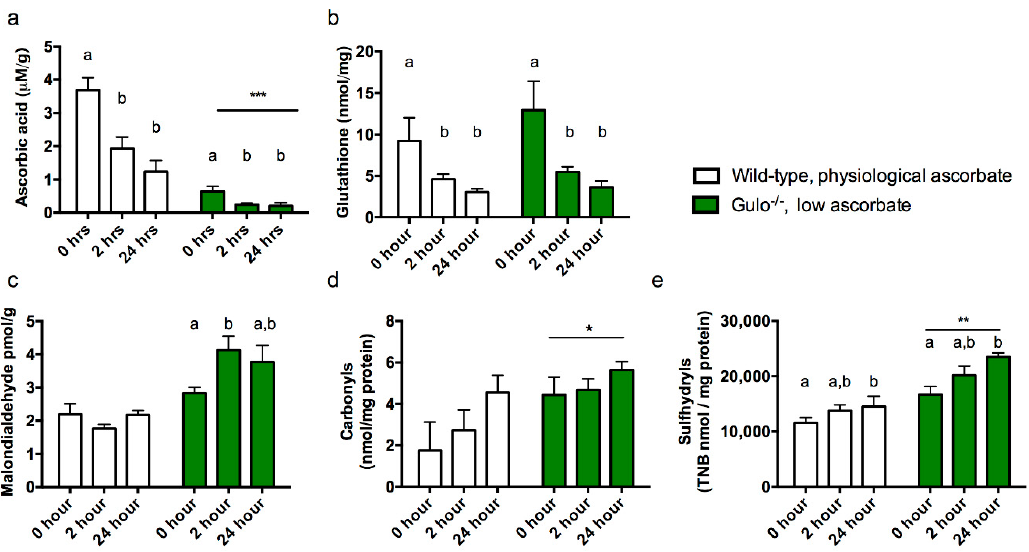
Figure 2. Antioxidant and oxidative stress markers in cortex of wild-type and gulo − / − mice maintained at a supplement level of 0.03 g/L ascorbate in drinking water. ( a ) Ascorbic acid, ( b ) total glutathione, ( c ) malondialdehyde, ( d ) protein carbonyls and ( e ) sulfhydryl measurements from cortex at 0 h, 2 h and 24 h after sacrifice (post mortem interval, PMI). Asterisks denote main effects of ascorbate level (group) *, **, *** p < 0.05, 0.01, 0.001 respectively, whereas differing letters signify a main effect of PMI. Bars that do not share a letter differ from other cases within the same group at p < 0.05.